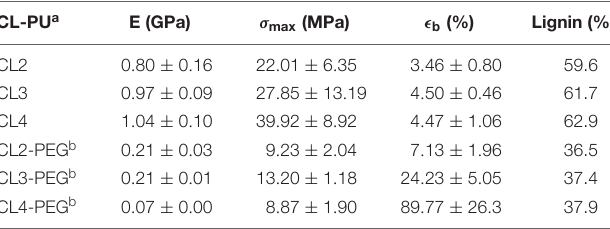
TABLE 3 | The tensile properties of CL-PUs: Young’s modulus (E), ultimate stress ( σ max ) and elongation at break ( (cid:15) b